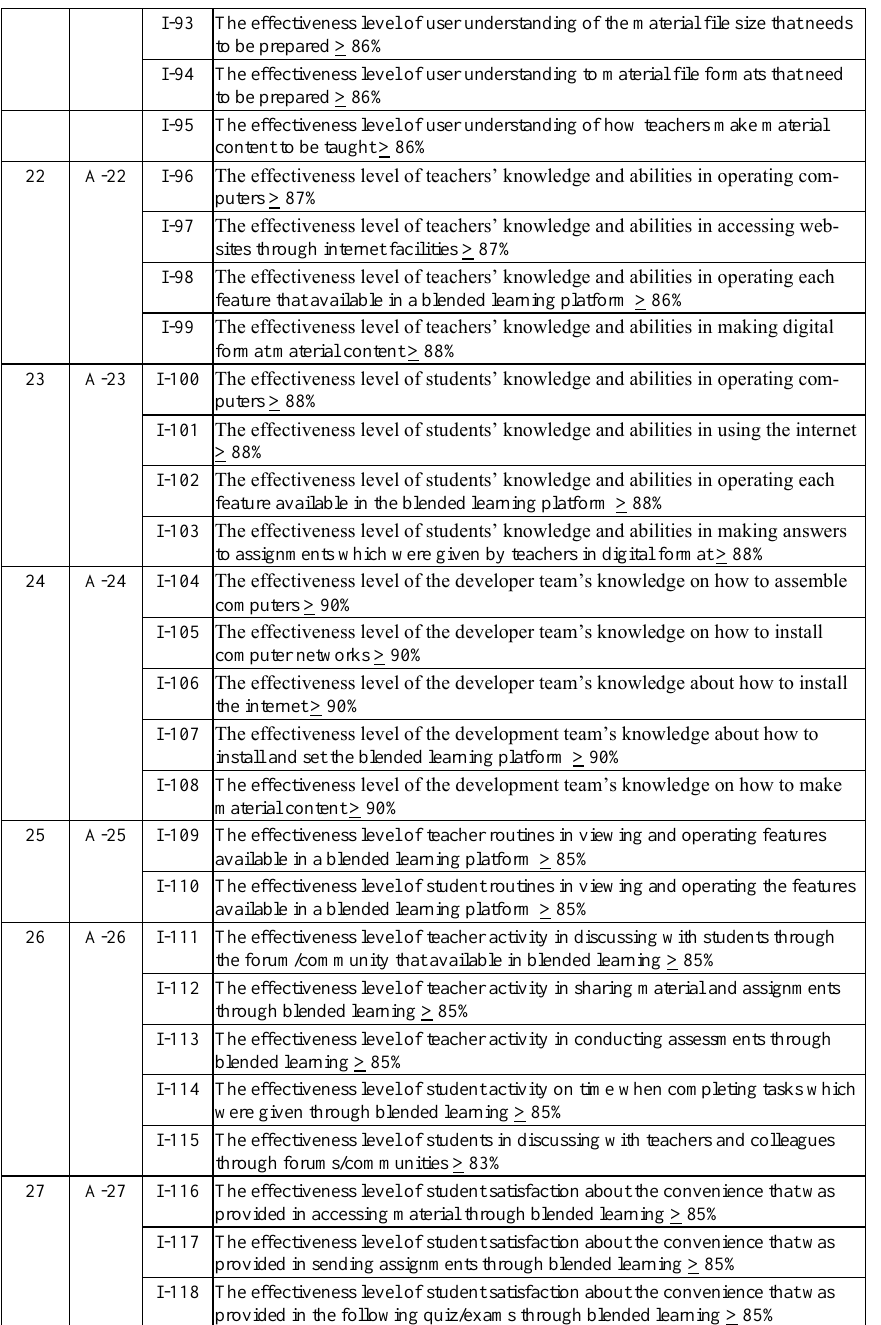
Paper — Instruments Development of Tri Kaya Parisudha-Based Countenance Model in